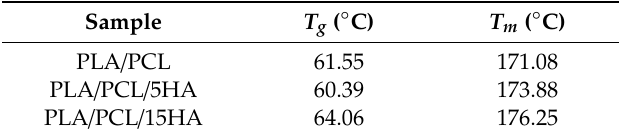
Figure 5. Differential scanning calorimetry (DSC) results of the extruded composite filaments. Table 3. Glass transition temperature ( T g ) and melting point ( T m ) of the composite filaments, obtained from DSC